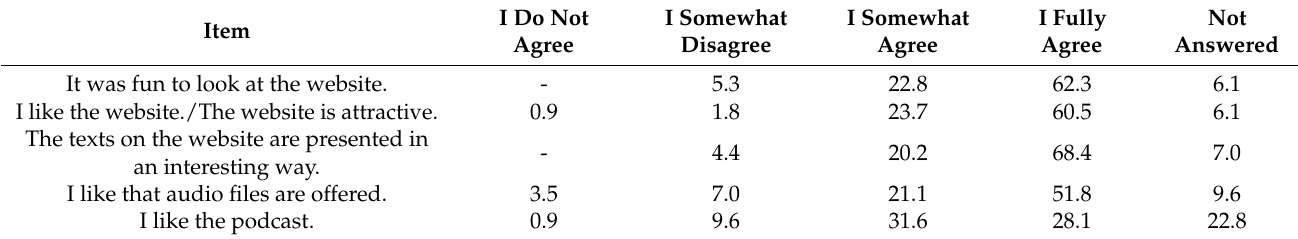
Table 3. Response rates to the statements about the attractiveness of the website (in percent, N = 114).